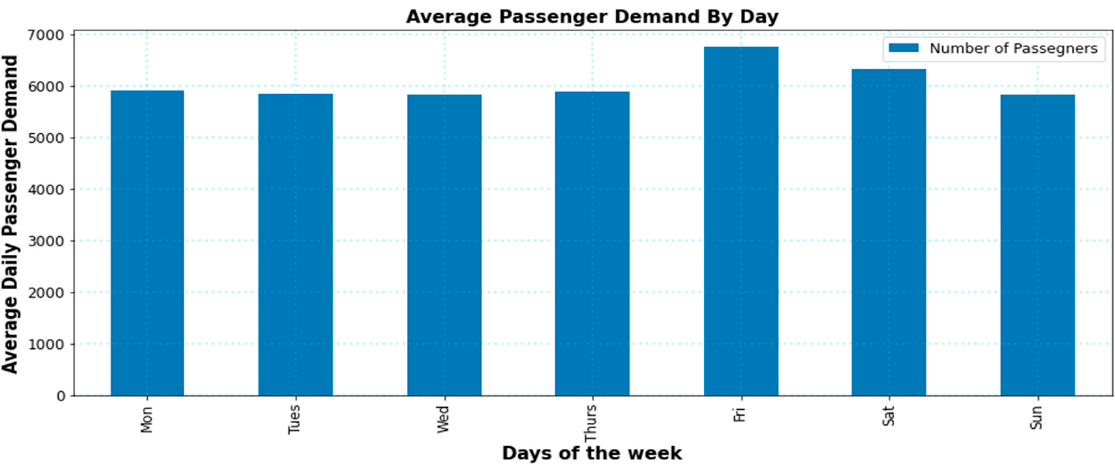
Figure 11. Bar plot of Figure 10. Figure 12 define the forecasted daily passenger demand for the additional 365 days using the Prophet model. As shown in the Figure 12, the black dots represent the actual training data, the blue lines represent time series model predictions, and the shaded area represents the 95% prediction interval (upper and lower).